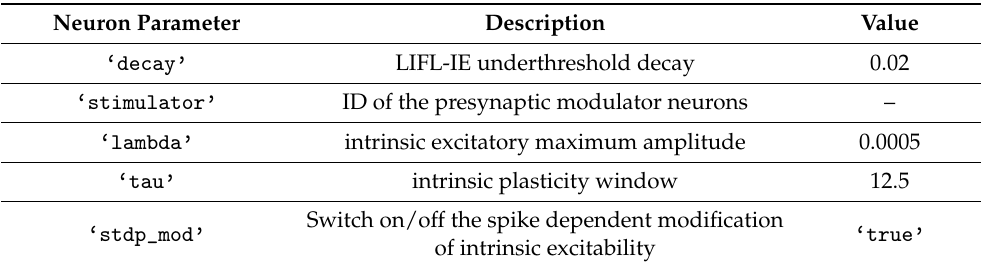
Table 1. Most important neuron parameters of ‘ lifl_psc_exp_ie ’ model for the NEST extension module ‘LIFL_IE’ , used to simulate the simple